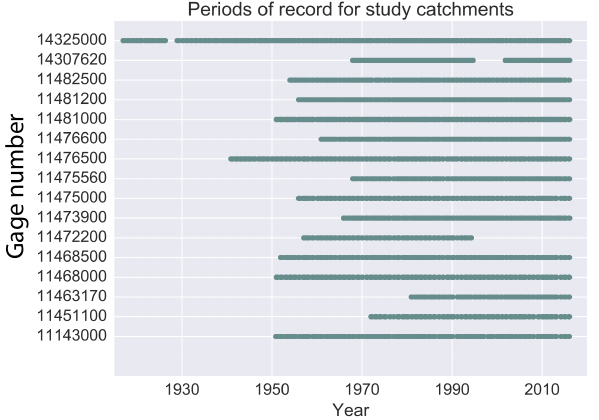
Figure 1. Green lines correspond to periods during which stream- flow data were available for each catchment.